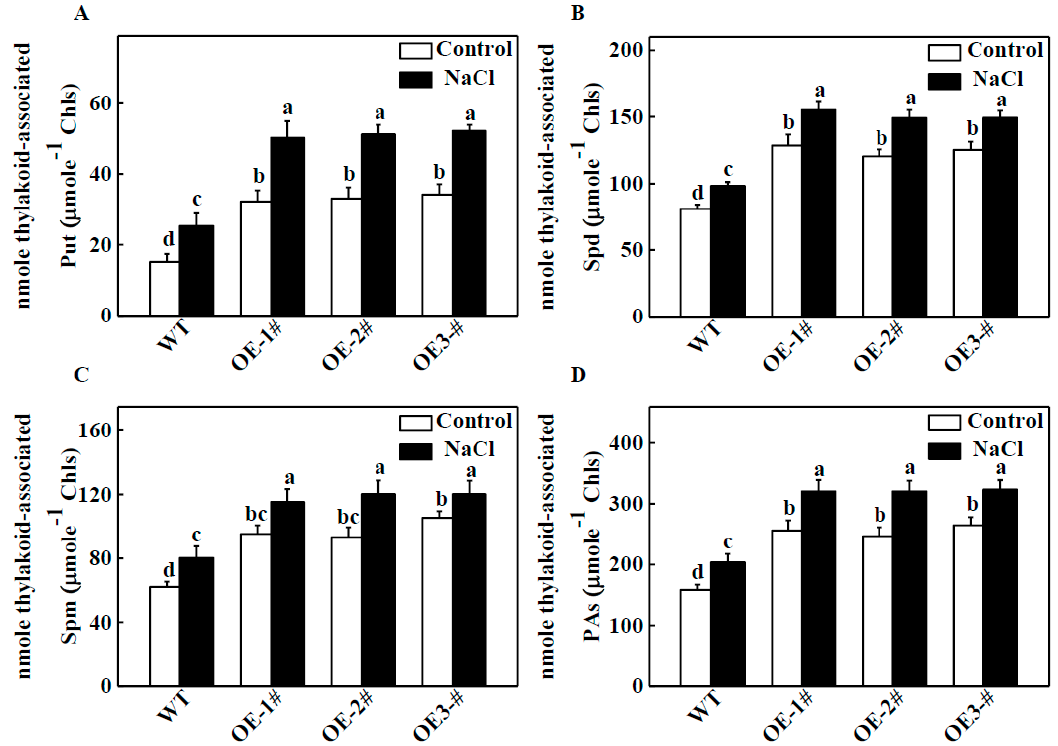
Figure 5. Effects of salt stress on the contents of endogenous putrescine (Put), spermidine (Spd), spermine (Spm) and total polyamines (PAs) in chloroplast of WT and CsTGase OE plants. ( A ) Thylakoid-associated Put content. ( B ) Thylakoid-associated Spd content. ( C ) Thylakoid-associated Spm content. ( D ) Total thylakoid-associated PAs content. Each histogram represents a mean ± SE of three independent experiments ( n = 4). Different letters indicate significant differences between treatments ( p < 0.05) according to Duncan’s multiple range test.